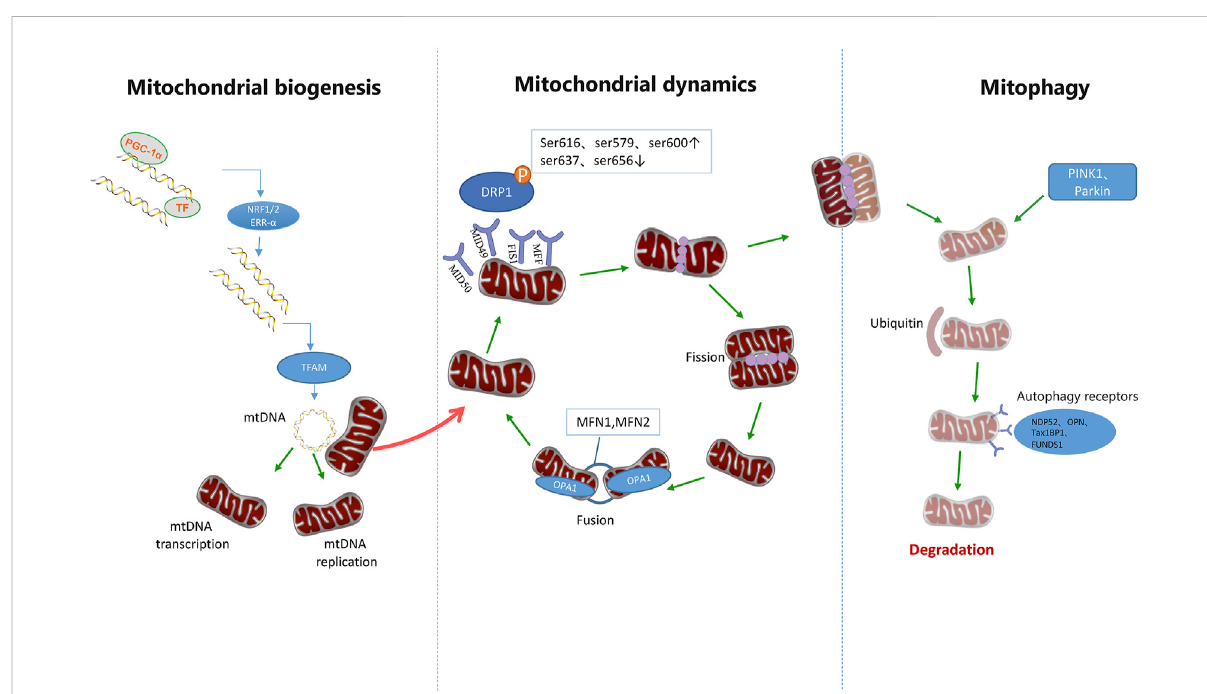
FIGURE 3 Mitochondrial quality control pathways. Mitochondrial homeostasis is ensured through the coordination of mitochondrial biogenesis, dynamics,andmitophagy.ThebiogeneticpathwayofmitochondriaisinitiatedbyPGC-1andthenstimulatesthenucleartranscriptionfactorsNRF-1, NRF-2, and ERR- α . It is then initiated by increasing the expression of TFAM, which is the fi nal effector of mtDNA transcription and replication. After translocation of phosphorylated DRP1 to mitochondrial OMM, it combines with Fis1, MID49/51, and MFF receptors to form a ring structure. Further contraction of this structure can promote mitochondrial division. However, DRP1 phosphorylation at Ser637 and Ser656 inhibits mitochondrial division, and DRP2 phosphorylation at Ser616, Ser579, and Ser600 promotes mitochondrial division. Mitochondrial fusion is accomplished by the fusion of the outer and inner membranes of adjacent mitochondria. MFN1 and MFN2 mediate mitochondrial outer membrane fusion, while OPA1 mediates mitochondrial inner membrane fusion. Mitochondrial components eventually circulate through a special autophagic pathway, known as mitochondrial phagocytosis. PINK1 and Parkin can activate mitosis of mitochondria and promote ubiquitination of outer membrane proteins of mitochondria, thus further promoting autophagic receptors such as NDP52, OPTN, TAX1BP1, and FUNDS1 to participate in the activation of